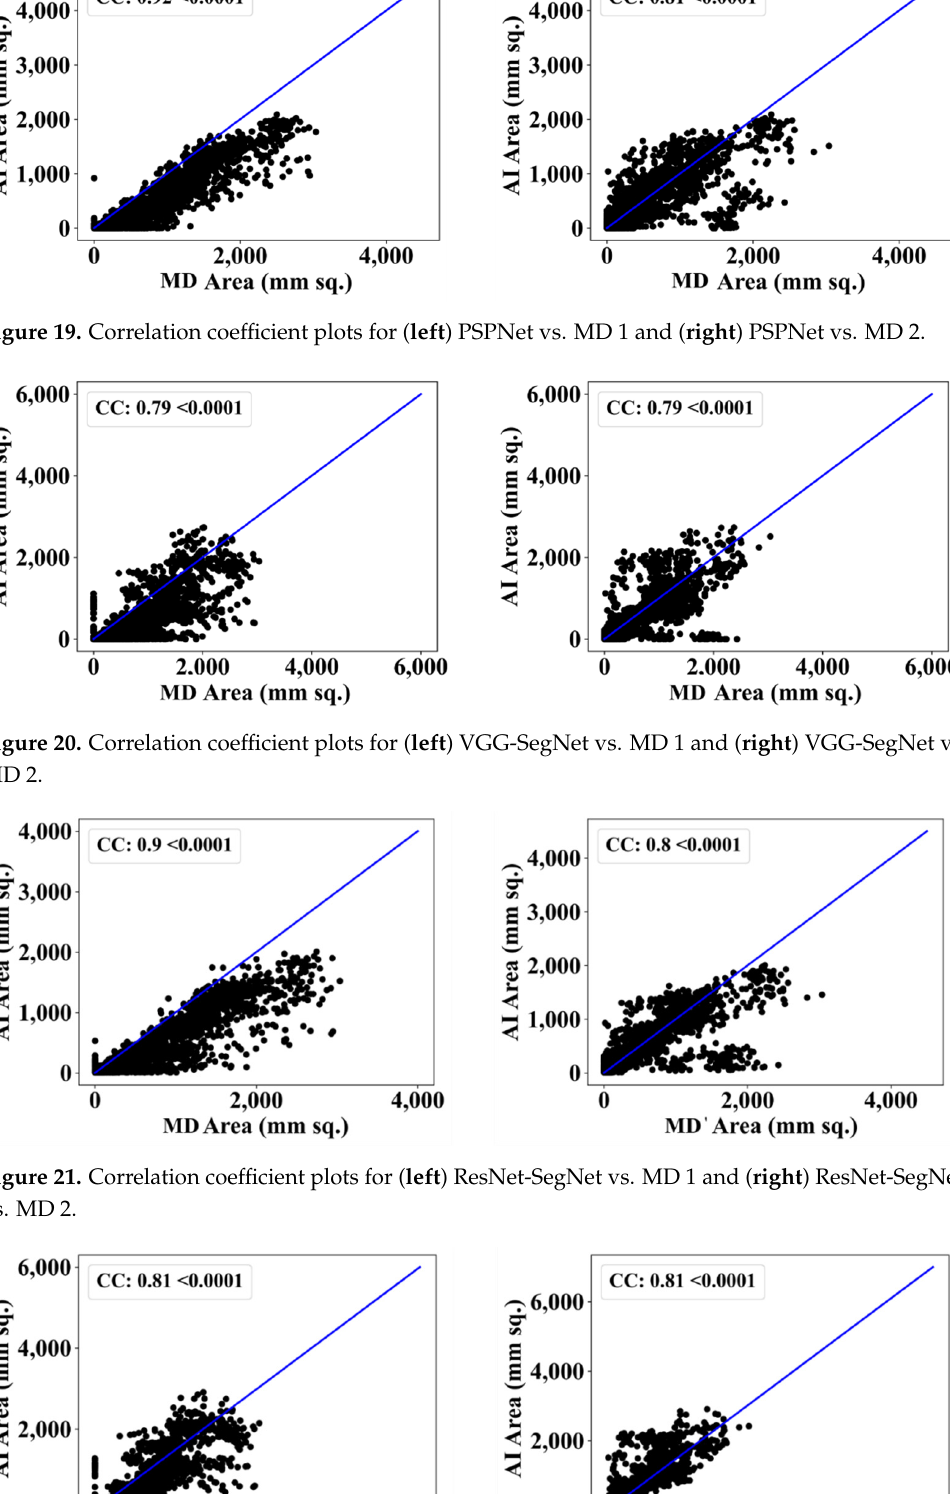
Figure 23. Correlation coefficient plots for (left) ResNet ‐ UNet vs. MD 1 and (right) ResNet ‐ UNet vs. MD 2.